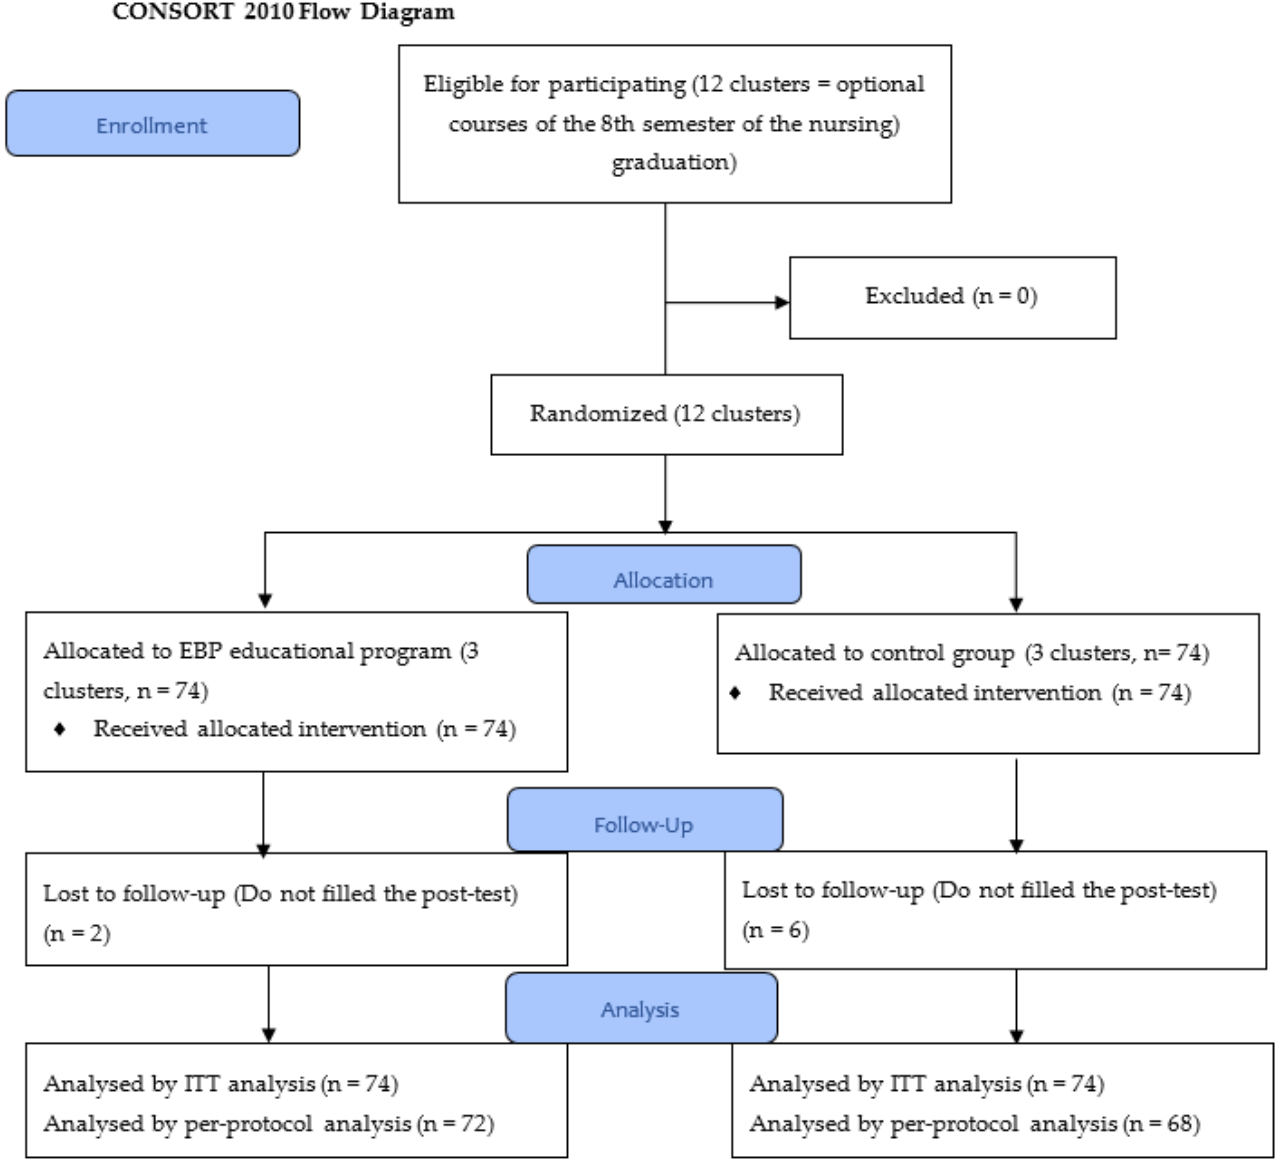
Figure 1. Consolidated Standards of Reporting Trials (CONSORT) diagram showing the flow of participants through each stage of the trial. ITT: